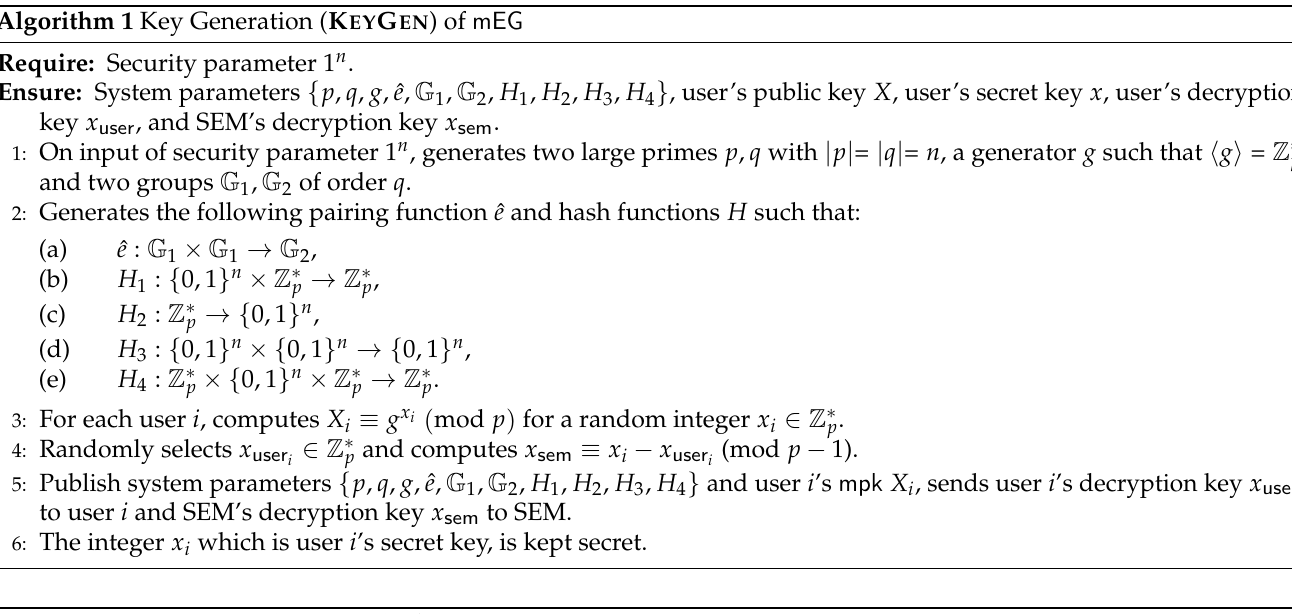
Algorithm 2 Encryption ( E NCRYPT ) of mEG